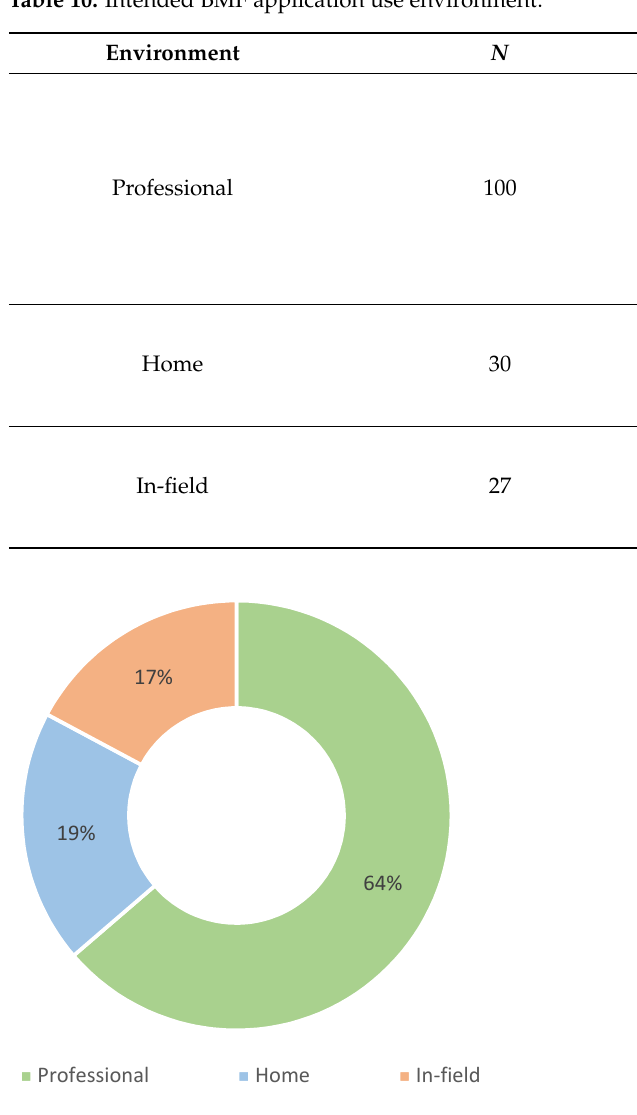
Table 10. Intended BMF application use environment.